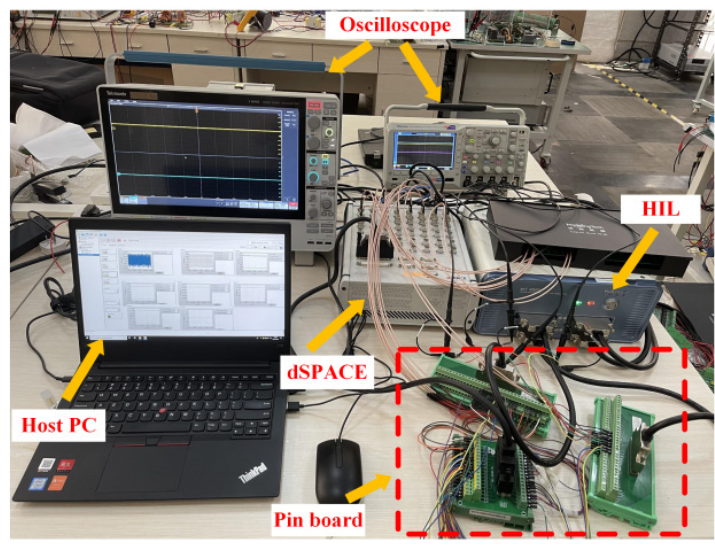
Figure 5. Experimental platform. Table 2. Main parameters of system